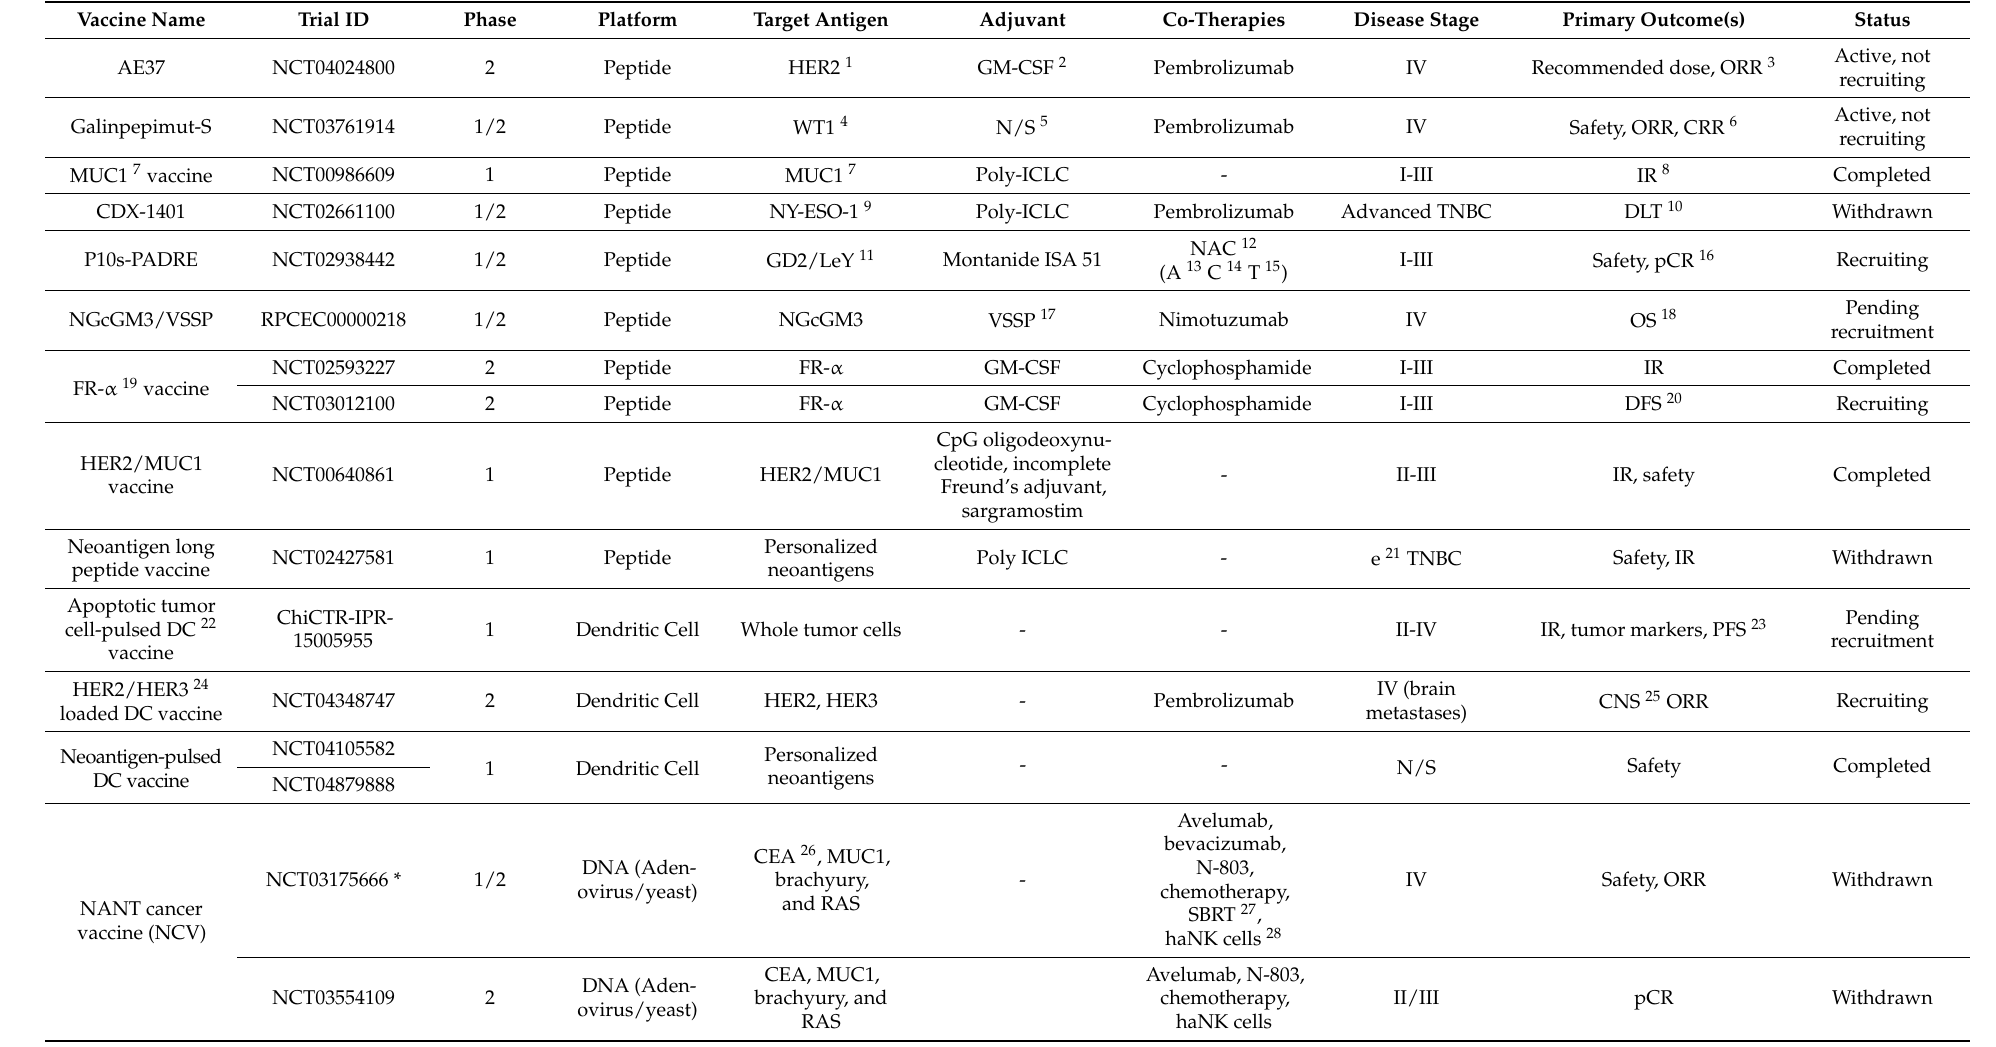
Table 3. Cancer vaccines in TNBC, based on unpublished data (registered trials). Non-randomized trials are marked with